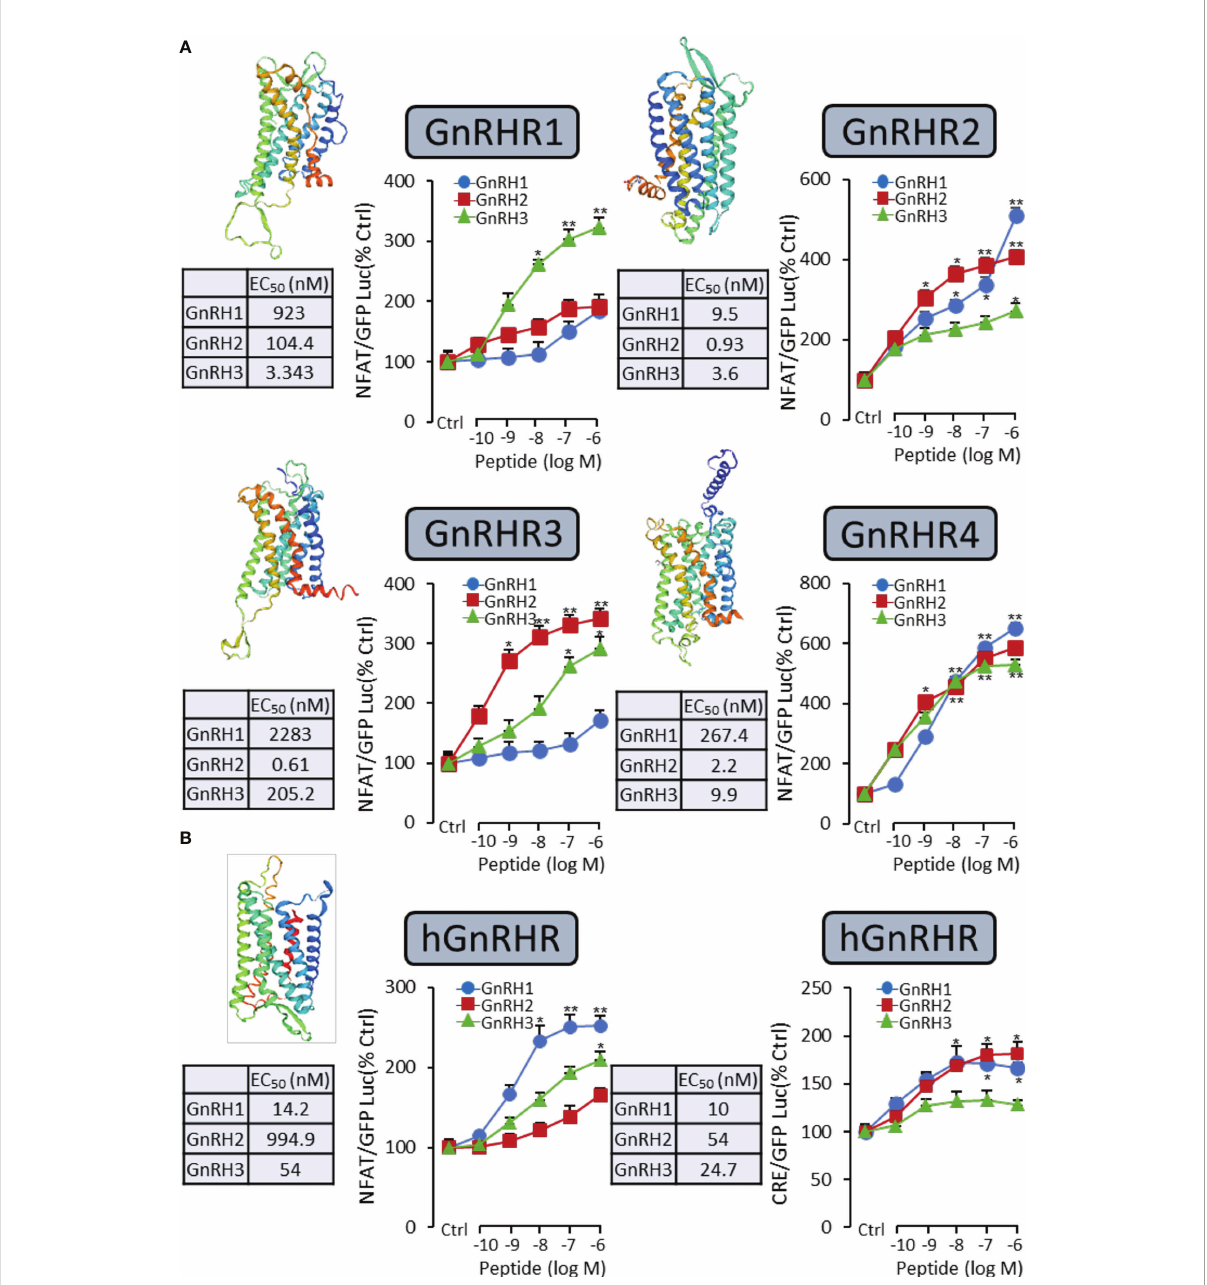
FIGURE 2 Functional analysis of grass carp GnRHRs and human GnRHR in HEK-293T cells. To examine the ligand – receptor selectivity of the GnRHs for GnRHRs, the NFAT-Luc or CRE-Luc reporter system was used in HEK-293T cells which were treated with various concentrations of GnRHs for 24 h, to detect the luciferase activity of GnRHs for grass carp GnRHR1, GnRHR2, GnRHR3, GnRHR4 (A) , and hGnRHR (B) . Each point was determined in quadruplicate, and data presented were expressed as mean ± SEM. p < 0.05 ( “ * ” ) or p < 0.01 ( “ ** ” ) was used to present signi fi cant differences among each